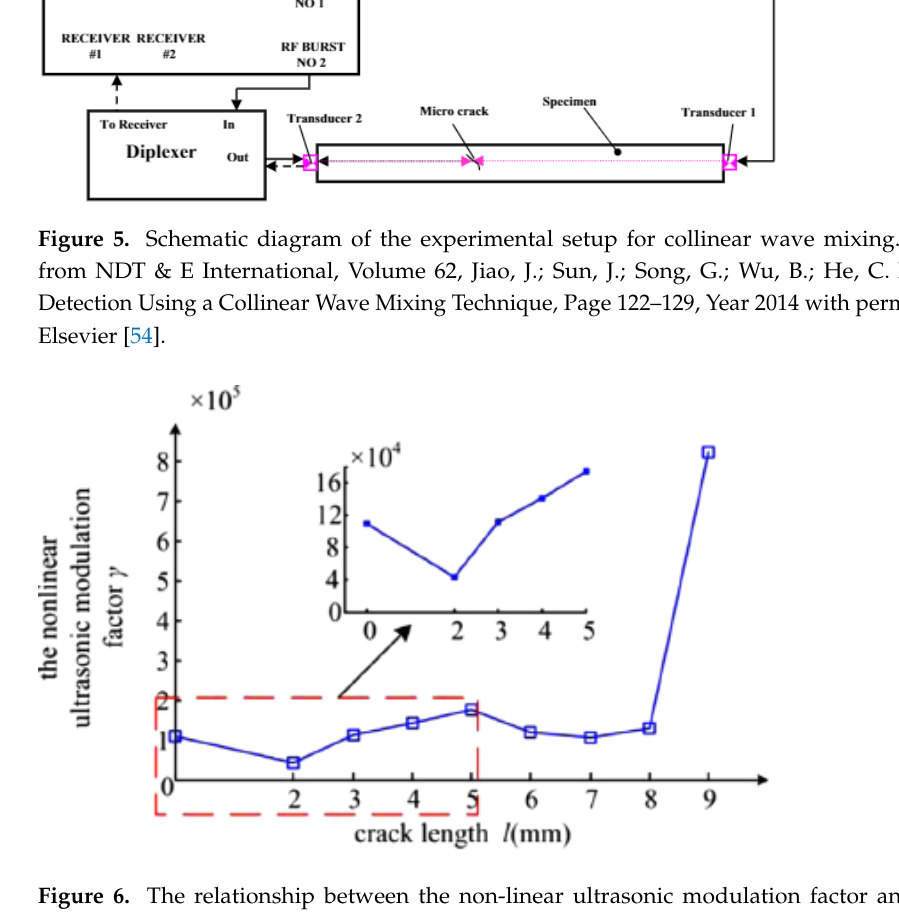
Figure 6. The relationship between the non-linear ultrasonic modulation factor and the crack length.Reprinted from NDT & E International, Volume 79, Li, N.; Sun, J.; Jiao, J.; Wu, B.; He, C. Quantitative Evaluation of Micro-cracks Using Non-linear Ultrasonic Modulation Method, Page 63–72, Year 2016 with permission from Elsevier